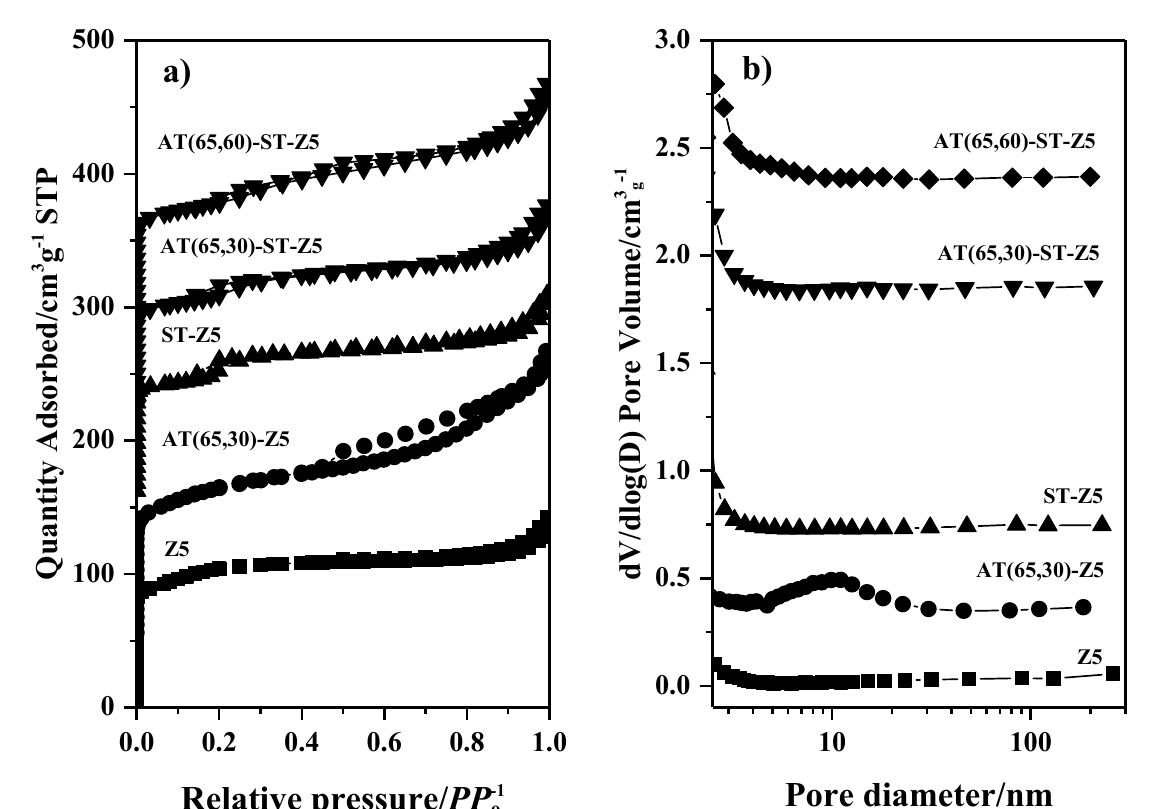
Figure 7. ( a ) N 2 adsorption-desorption isotherms of steaming-alkaline treated samples. ( b ) BJH pore size distribution derived from the adsorption branches of the isotherms. The isotherms for AT(65,30)-Z5, ST-Z5, AT(65,30)-ST-Z5 and AT(65,60)-ST-Z5 were offset vertically by 50, 150, 220 and 270 cm 3 g − 1 , respectively. ( b ) Barrett–Joyner–Halenda (BJH) pore size distribution (PSD) data derived from the adsorption branches of the isotherms. The PSD curves of AT(65,30)-Z5, ST-Z5, AT(65,30)-ST-Z5 and AT(65,60)-ST-Z5 were offset vertically by 0.3, 0.7, 1.8 and 2.3 cm 3 g − 1 , respectively.